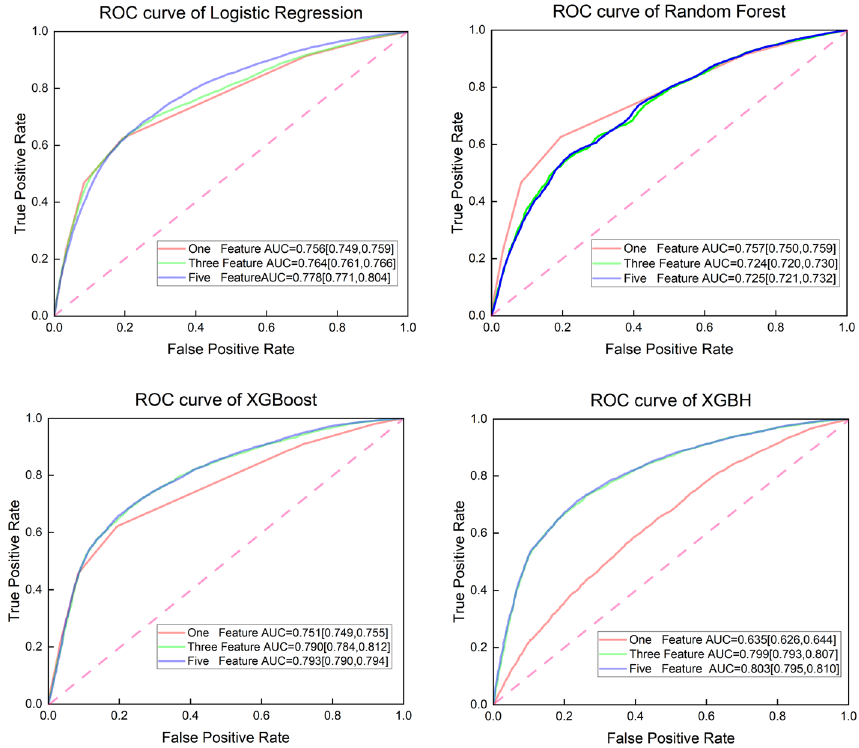
Figure 2. ROC curve, compare the AUC of the four models with different characteristics.